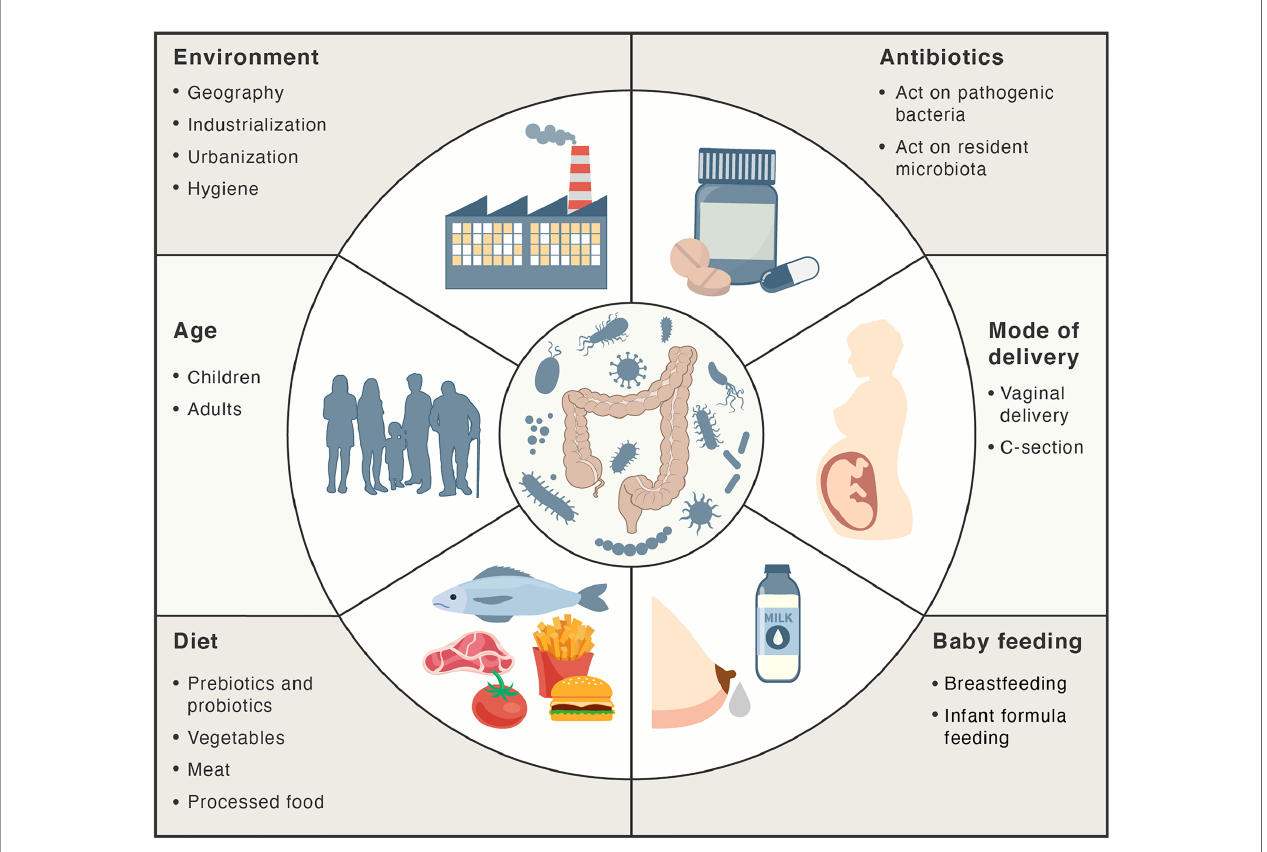
FIGURE 2 | Main factors in fl uencing the gut microbiota. Factors, such as mode of delivery, type of baby feeding, diet, age, environment and antibiotics may act positively or negatively on the intestinal microbiota composition and